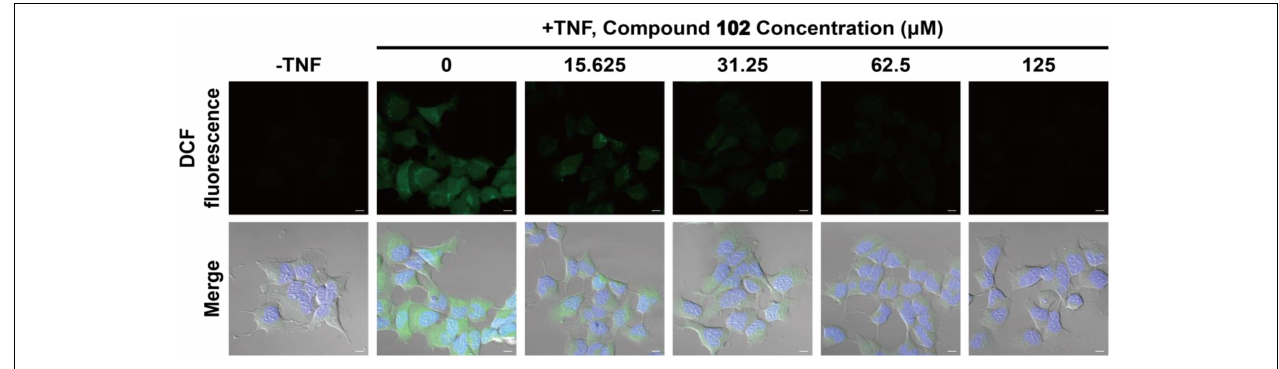
FIGURE 5 | Inhibition of intracellular ROS accumulation by different concentrations of GPX4 activator in HEK293T cells. The intracellular ROS level was assayed by confocal microscopy using the fluorescent probe DCFH-DA (green). Nuclei were stained with Hoechst 33342 (blue). Scale bars represent 10 µ m.